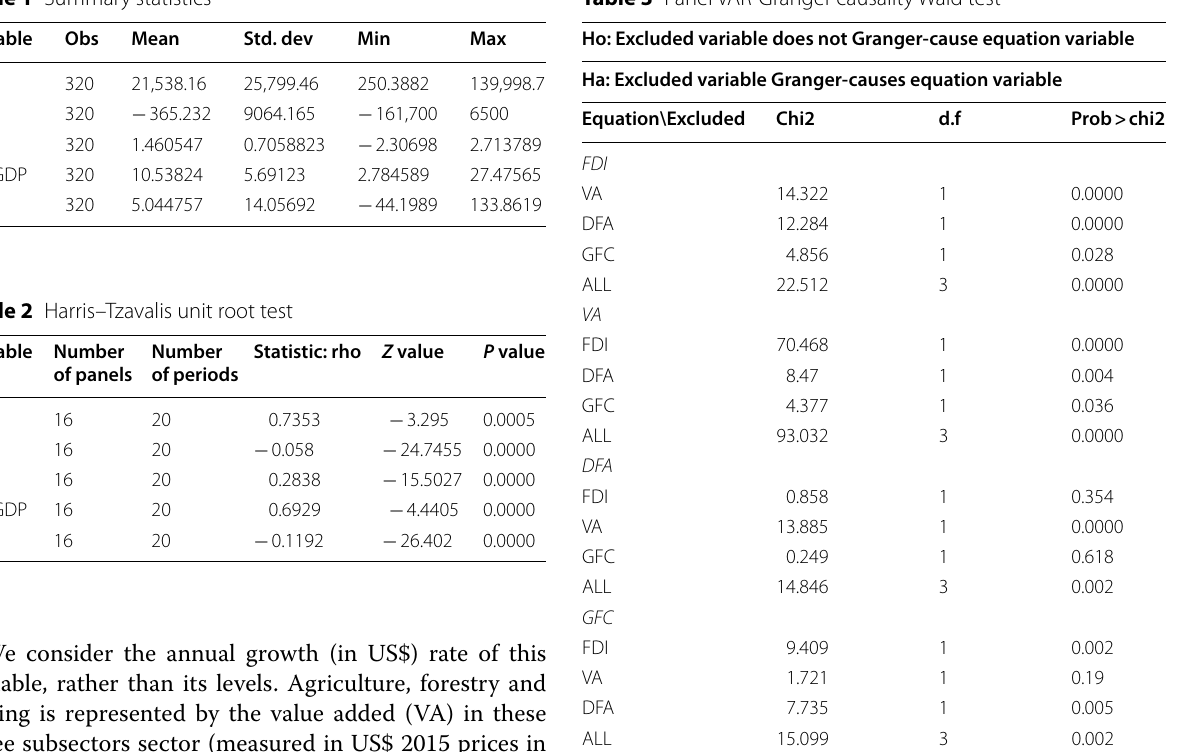
Table 3 Panel VAR-Granger causality Wald